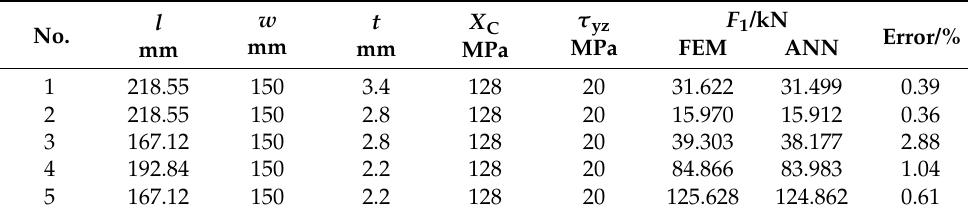
Table 7. Verification of calculation model for ultimate bearing capacity of the